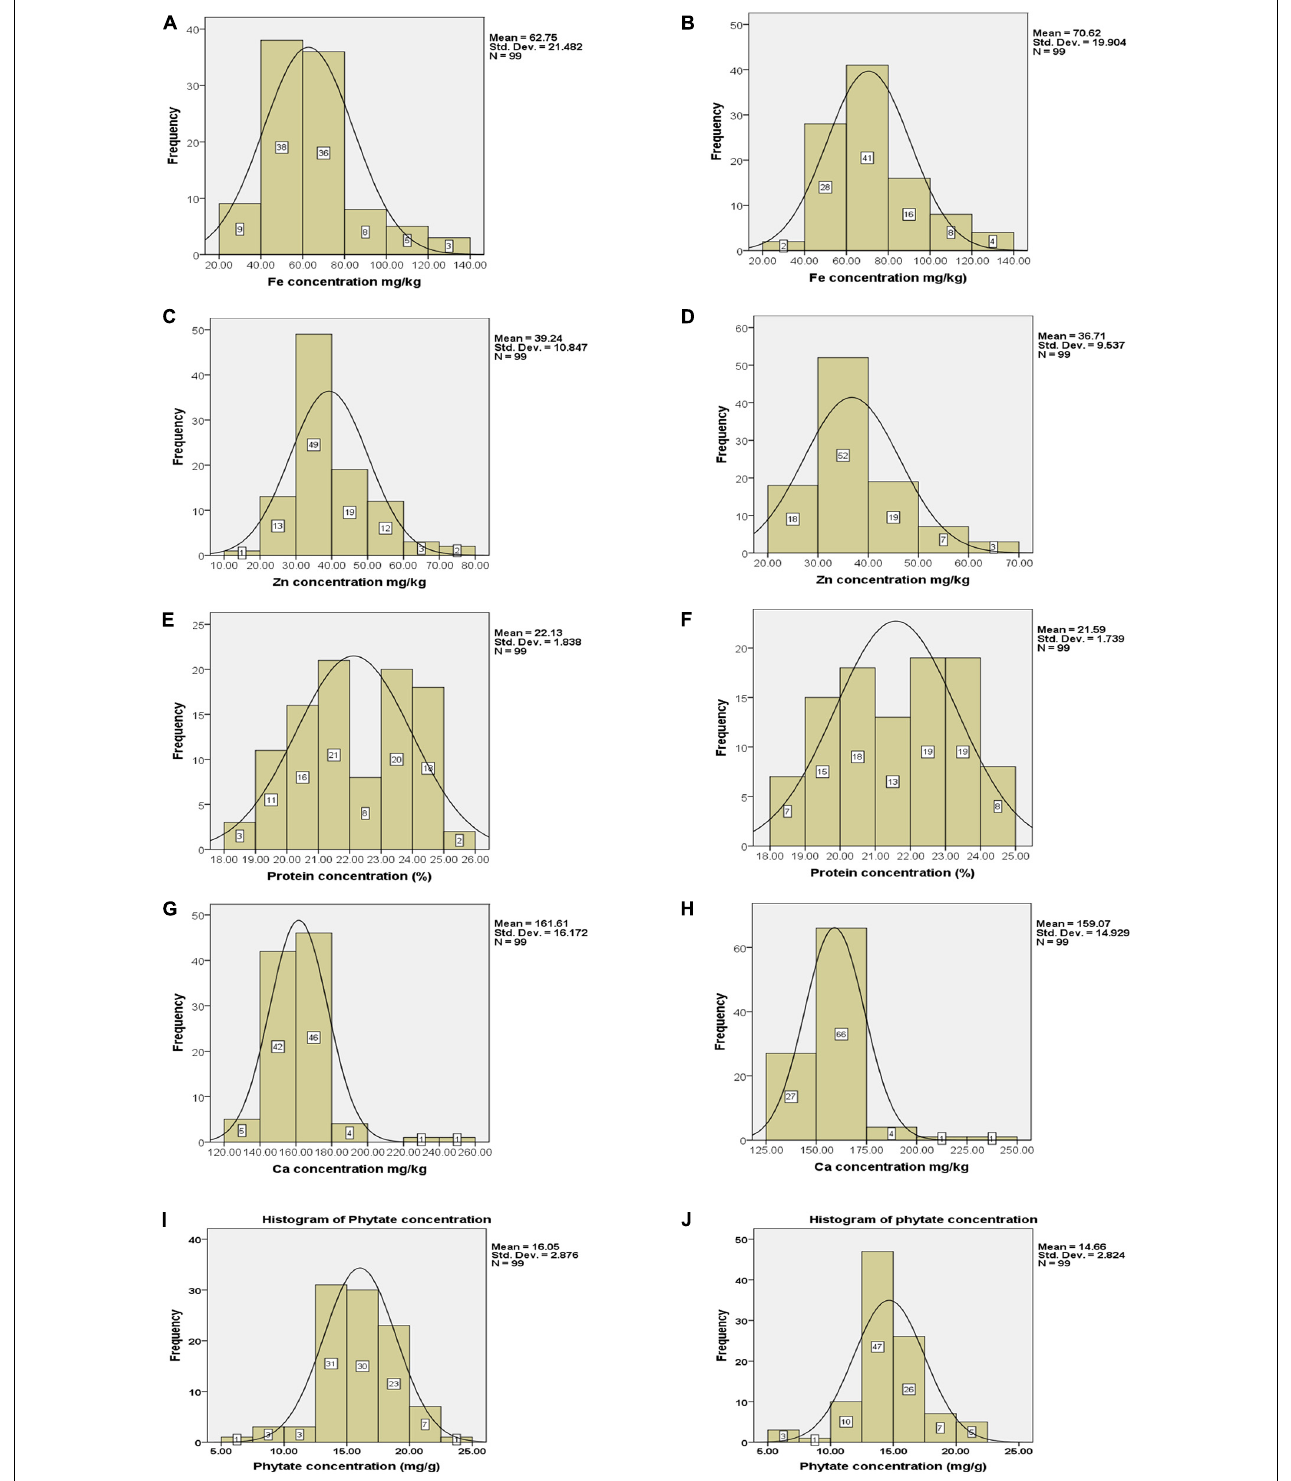
FIGURE 2 | Frequency distribution of Fe, Zn, Ca, protein, and phytate concentrations (A–J) in tested Vigna stipulacea accessions at Loc1 (ICAR-IIPR, Kanpur); and Loc2 (ICAR-NBPGR, New Delhi), respectively. (A) Fe concentrations at Loc1. (B) Fe concentrations at Loc2. (C) Zn concentrations at Loc1. (D) Zn concentrations at Loc2. (E) Ca concentrations at Loc1. (F) Ca concentrations at Loc2. (G) Protein concentrations at Loc1. (H) Protein concentrations at Loc2. (I) Phytate concentrations at Loc1. (J) Phytate concentrations at Loc2.